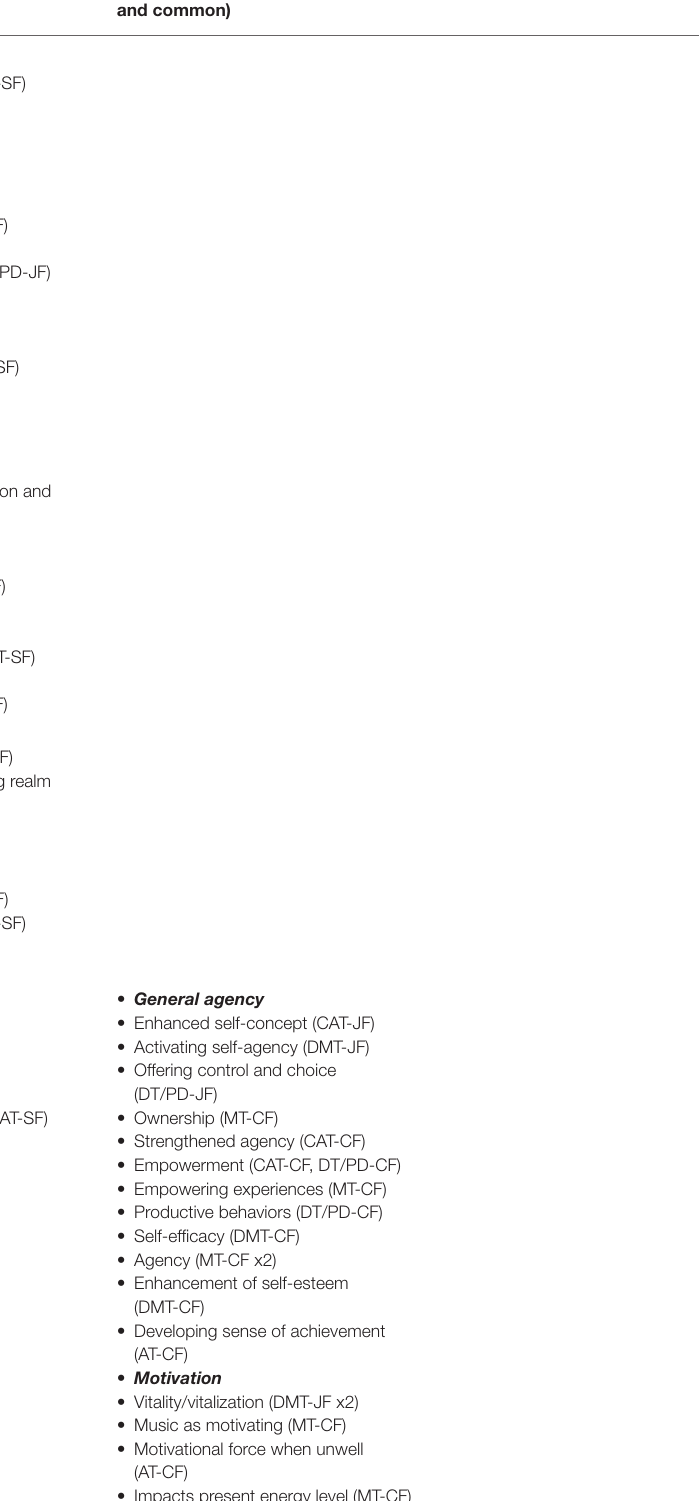
TABLE 4 | The 19 domains of therapeutic factors in the CATs. Domain of